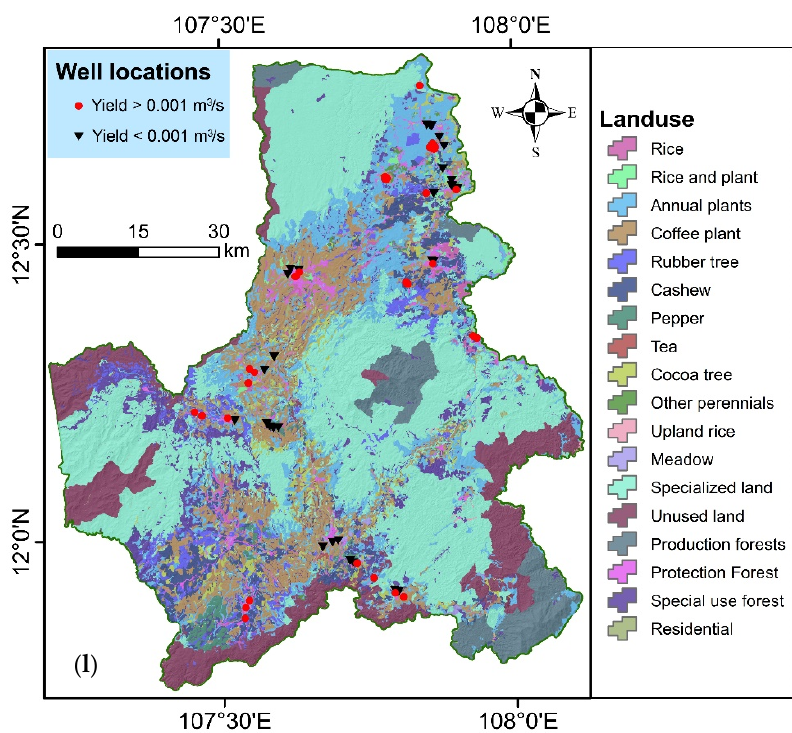
Figure 3. Maps of groundwater influencing factors: ( a ) infiltration, ( b ) rainfall, ( c ) river density, ( d ) Stream Power Index (SPI), ( e ) Sediment Transport Index (STI), ( f ) Topography Wetness Index (TWI), ( g ) elevation, ( h ) aspect, ( i ) curvature, ( j ) slope, ( k ) soil, and ( l ) land use.